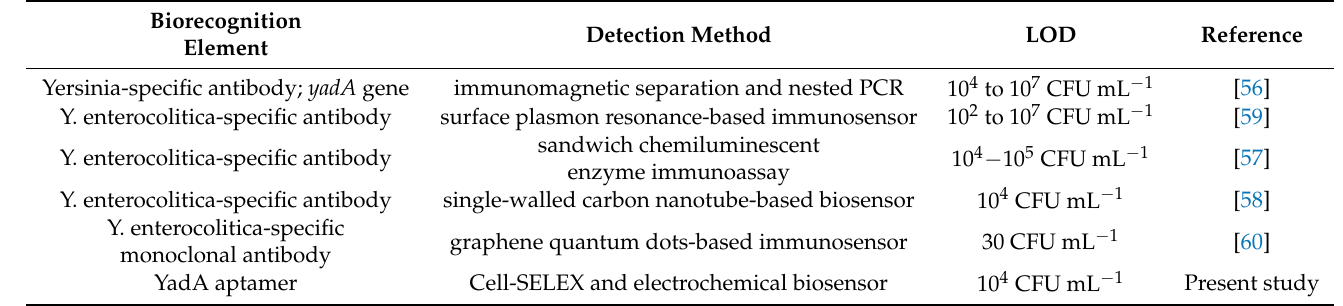
Table 3. Examples of previous studies on the detection of Yersinia enterocolitica and the LOD achieved in each study.